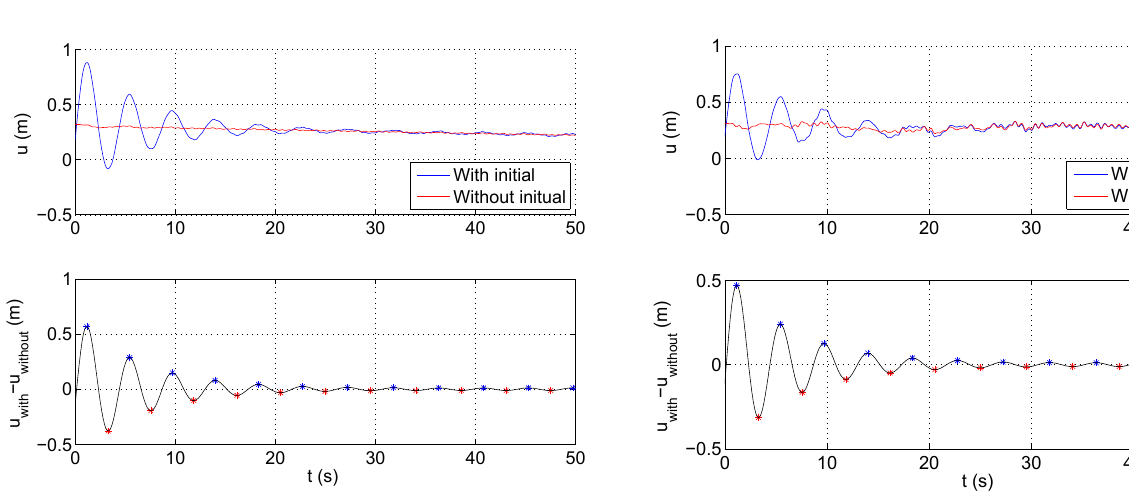
Figure 6. Decay test for a steady wind of 14ms − 1 . Figure 7. Decay test for a turbulent wind of 14ms − 1 .